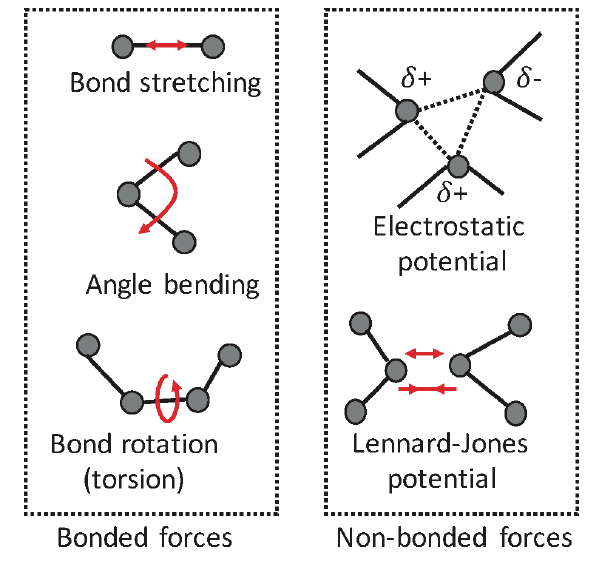
Fig. 2. Bonded and non-bonded forces consider in MD sim-